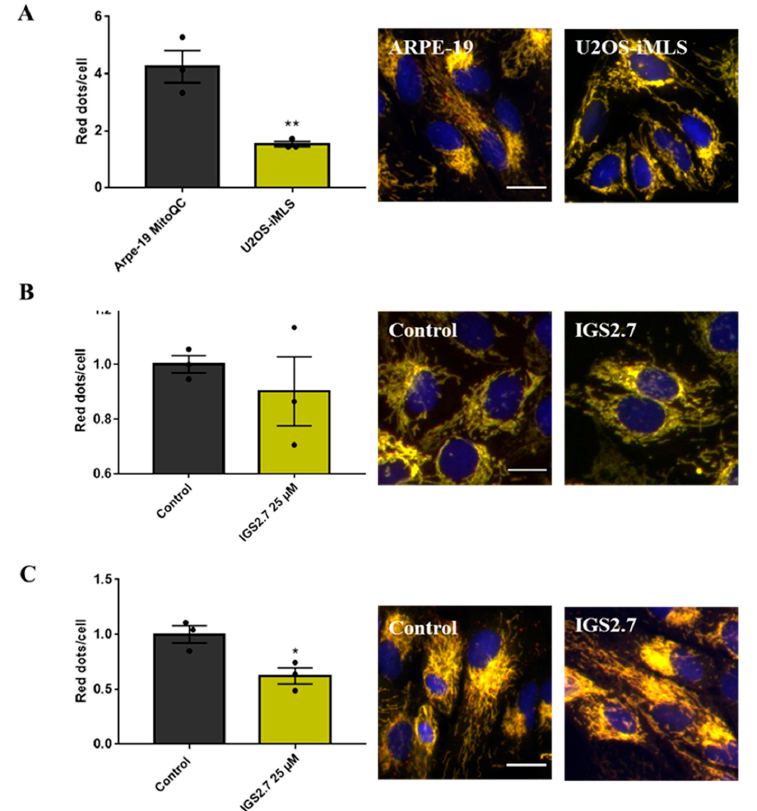
Figure 4. Basal mitophagy in ARPE-9 MitoQC and U2OS-iMLS cells and its modulation by IGS2.7. Representation and quantification of mitophagy in ( A ) ARPE-19 MitoQC and U2OS-iMLS cells, ( B ) U2OS-iMLS cells, and ( C ) ARPE-19 MitoQC cells treated with control and 25 µM IGS2.7 for 24 h. Data represent the mean ± SEM of three independent experiments. Data from ( B , C ) were normalized to control (significance was determined by unpaired two tailed t -test, where ** p < 0.01 indicates a significant difference between samples and * p < 0.05 indicates a significant difference from control). Scale bar = 20 µm.